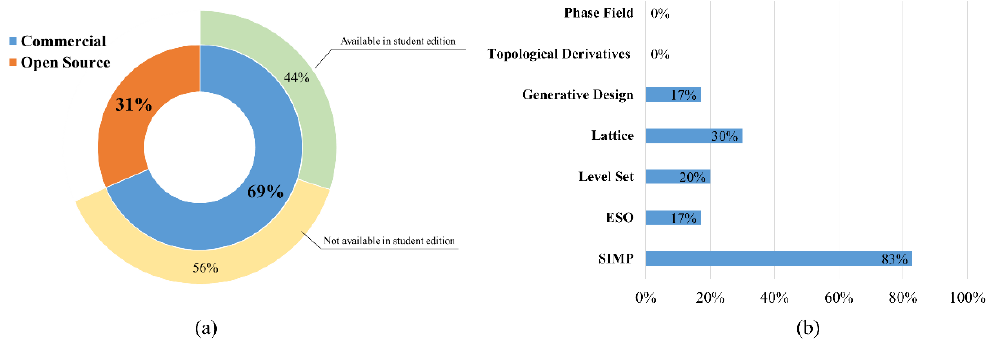
Figure 3. ( a ) Commercial vs. open source software, and ( b ) the availability of the different TO methods in software.